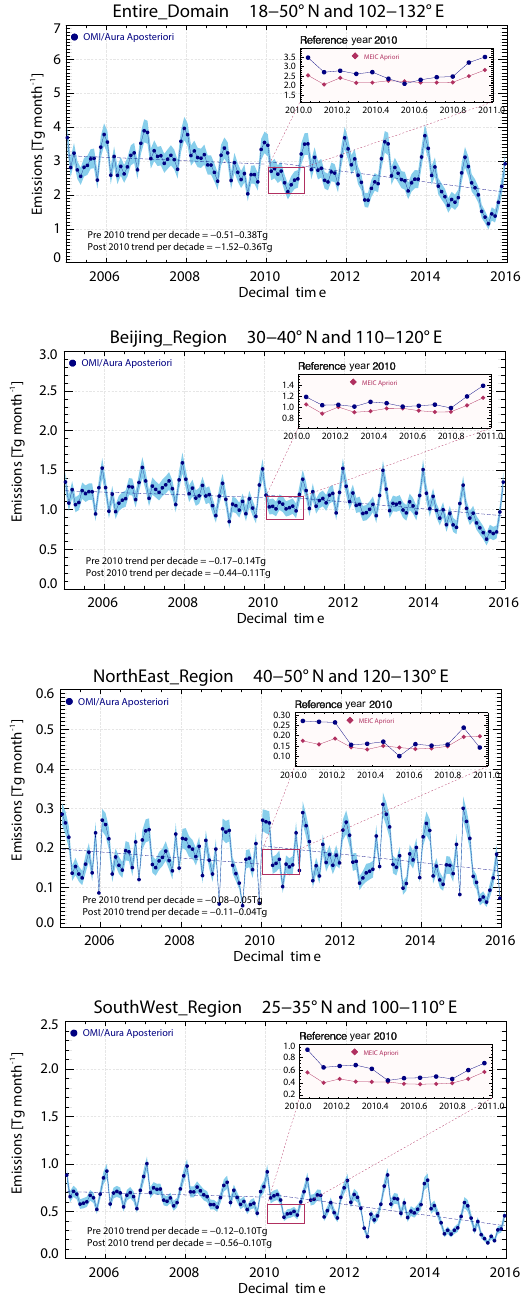
Figure 6. Monthly mean time series for the a posteriori emissions in teragrams per month calculated in this work (dark blue points) between 2005 and 2015. Insert: the reference year 2010 is shown to include the MEIC v1.2 a priori emissions in maroon diamonds. The light blue shaded area depicts the calculated a priori error (Eq. 7). (a) The entire domain studied (18–50 ◦ N, 102–132 ◦ E), (b) the greater Beijing region (30–40 ◦ N, 110–120 ◦ E), (c) the northeast region (40–50 ◦ N, 120–130 ◦ E) and (d) the southwest region (25– 35 ◦ N, 100–110 ◦